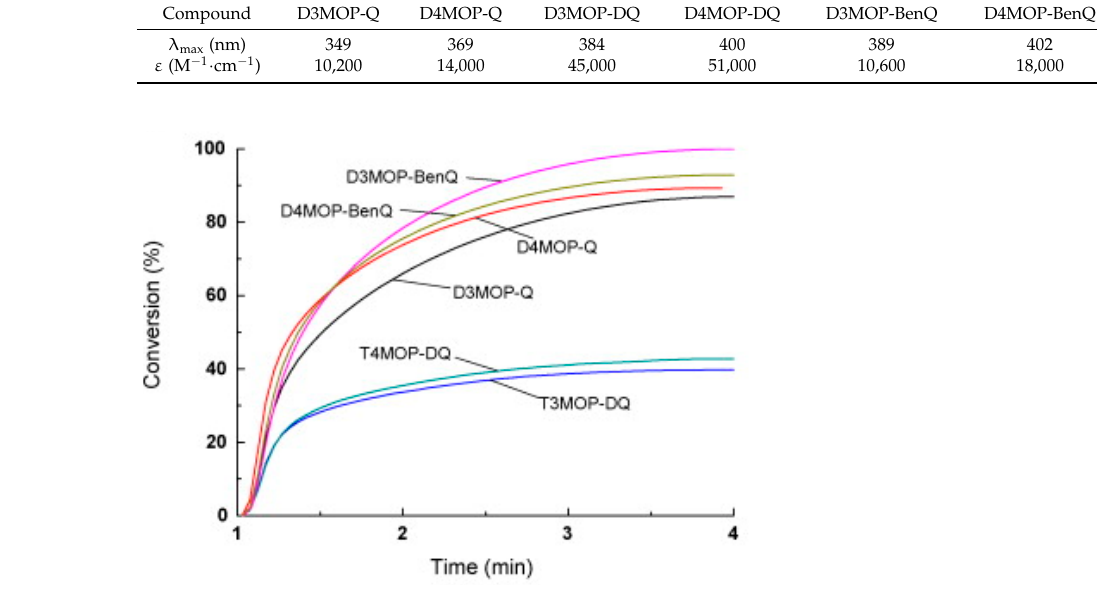
Figure 29. Photopolymerization profiles obtained with the two-component D3MOP-Q/MBO, D4MOP-Q/MBO, T3MOP-DQ/MBO, T4MOP-DQ/MBO, D3MOPBenQ/MBO and D4MOP- BenQ/MBO systems, upon irradiation at 365 nm (I = 50 mW/cm 2 ) during the FRP of A-BPE-10. Reprinted from Ref. [240], Copyright 2010, Elsevier.